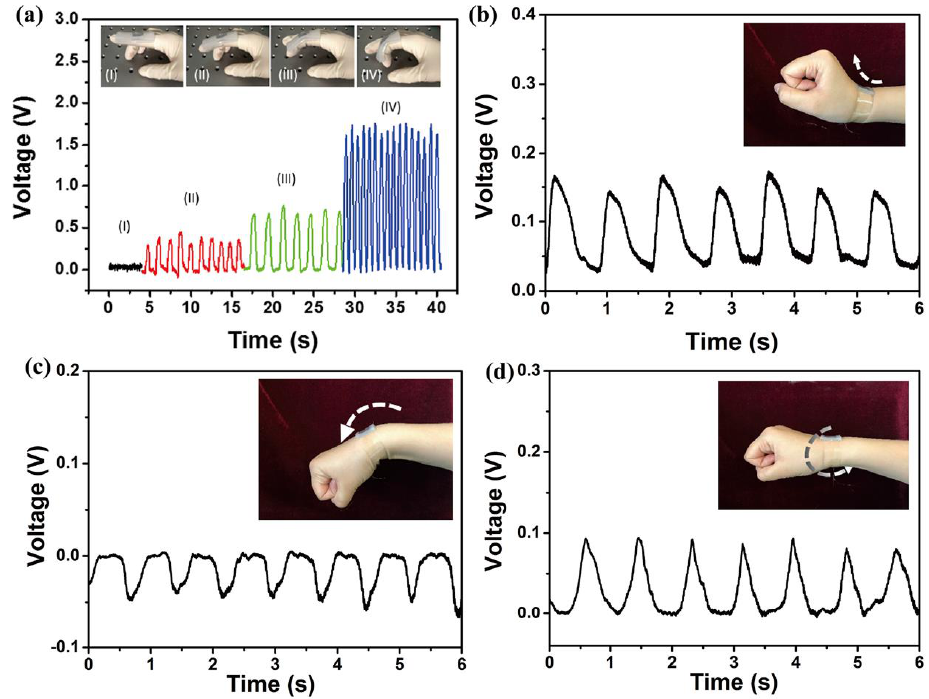
Figure 6. The piezoelectric pressure sensor used for detecting joint motion states. ( a ) The sensor used for detecting finger motion states. Change in generated voltage under different types of wrist movements: ( b ) upward bending, ( c ) downward bending, and ( d ) torsion.